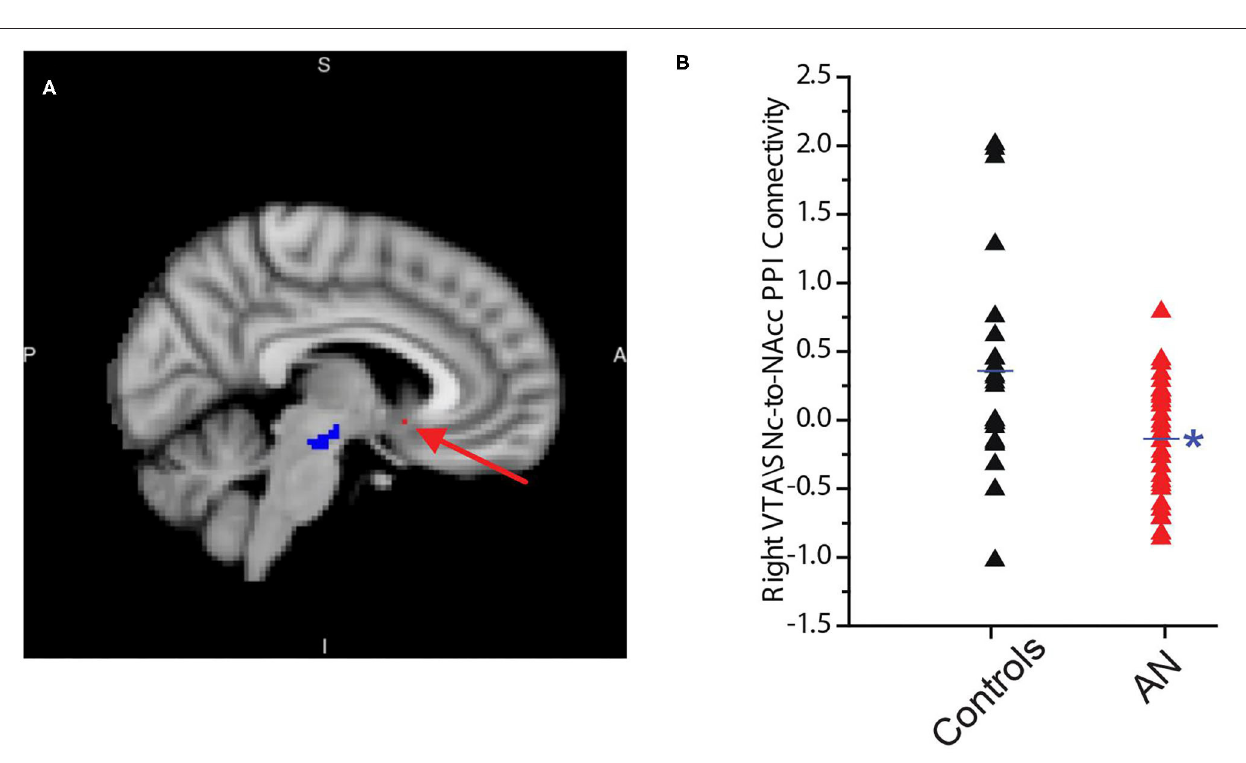
connectivity in the right VTA \ SNc-to-sphere and reaction time (r = 0.12, p = 0.26, partial correlation controlling for age, PDS score, and anxiety level after scan) or BAS drive score (r = − 0.005, p = 0.49, partial correlation controlling for age and PDS